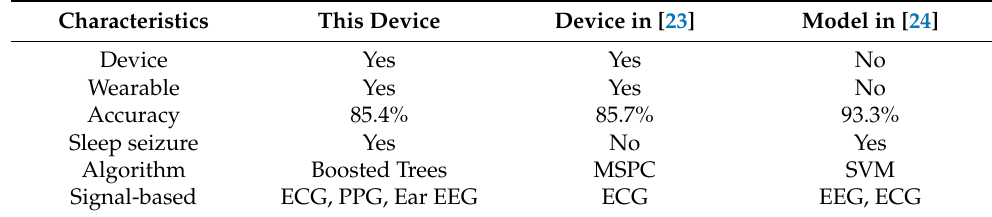
Table 4. Comparison of the developed model with other status epilepticus classification models.